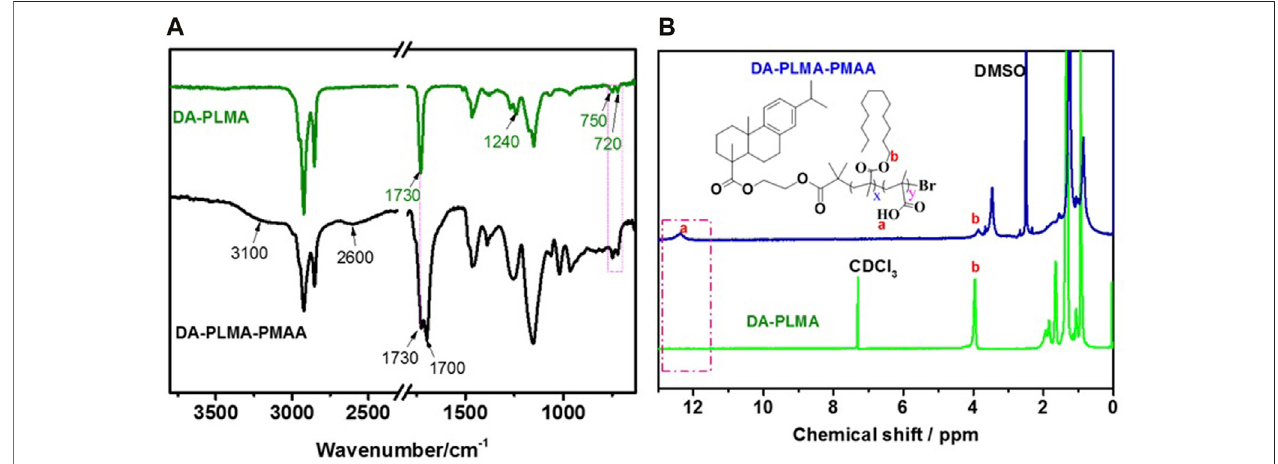
FIGURE 4 | Spectrum of DA-PLMA before and after hydrolysis (A) FT-IR and (B) 1 H NMR.